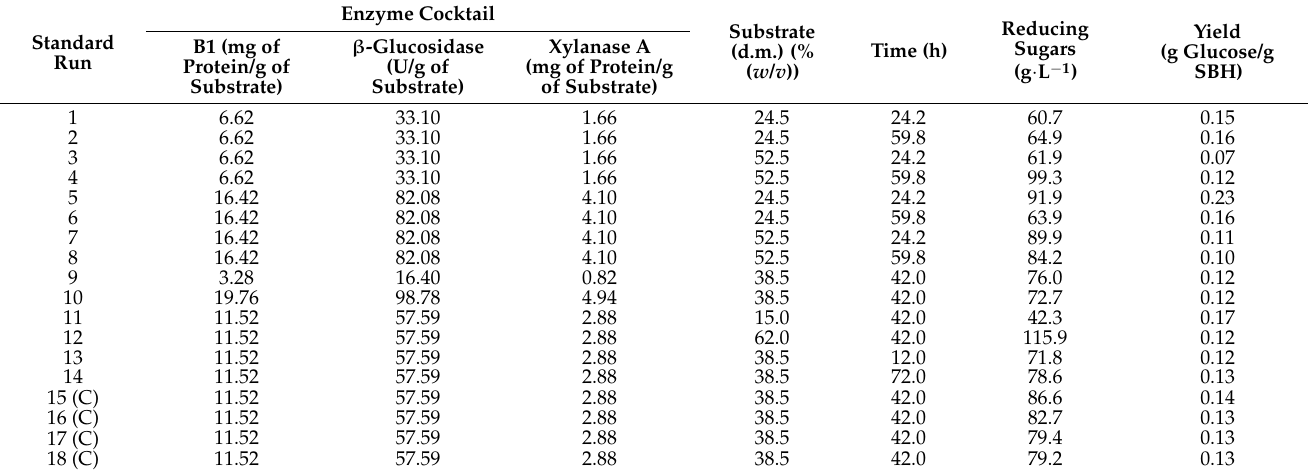
Table 3. Central composite design matrix for the SBH enzymatic hydrolysis